Question: Express in one sentence what the figure is showing.
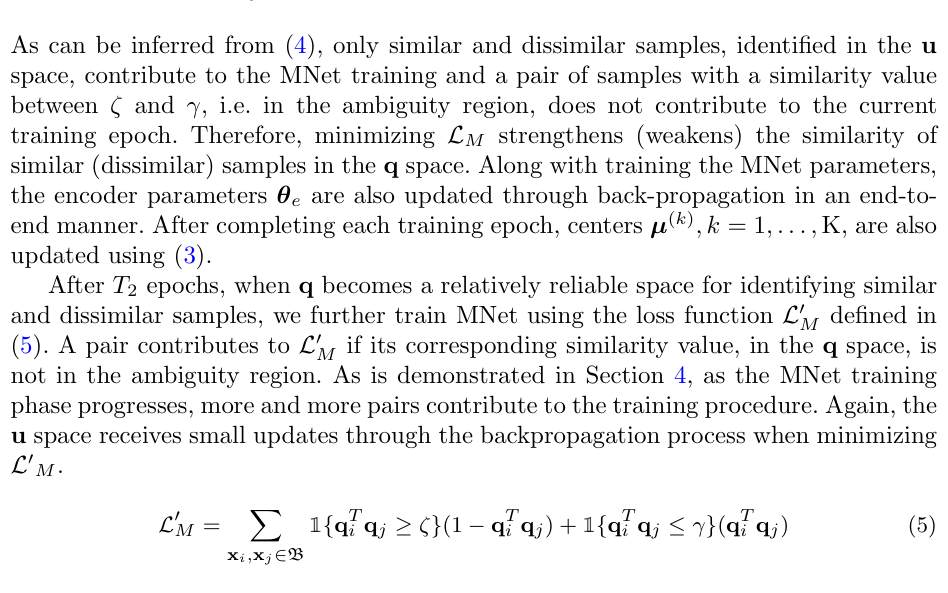
Answer: (b) shows the overall training procedure of the DCSS’s second phase.